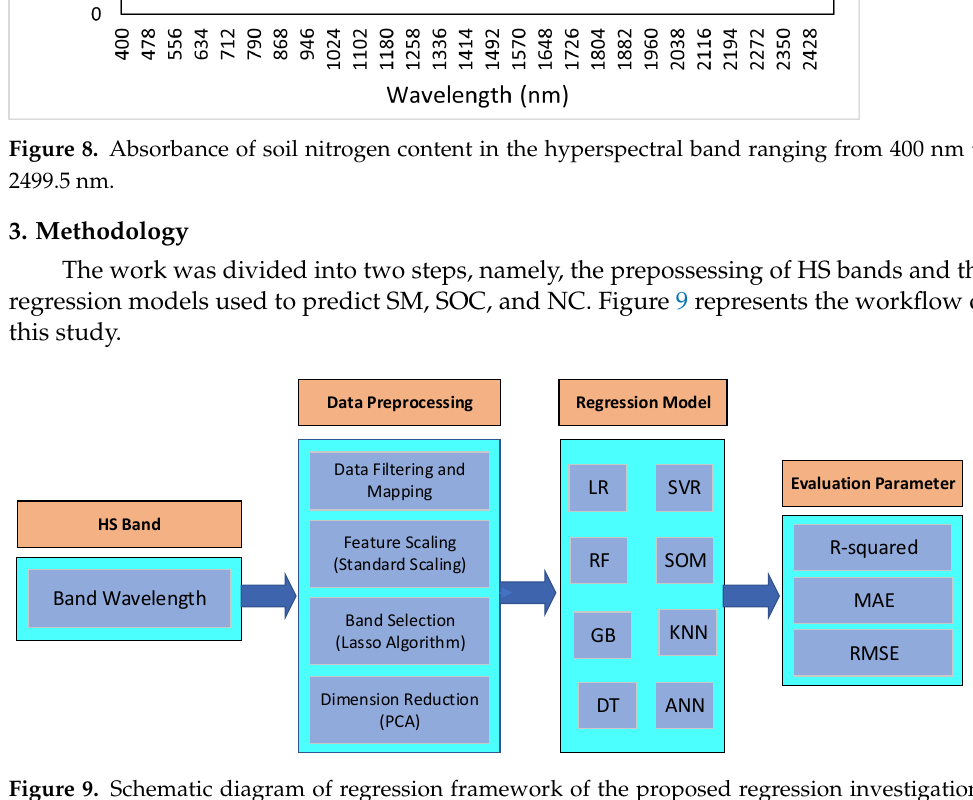
Figure 9. Schematic diagram of regression framework of the proposed regression investigations using different machine learning